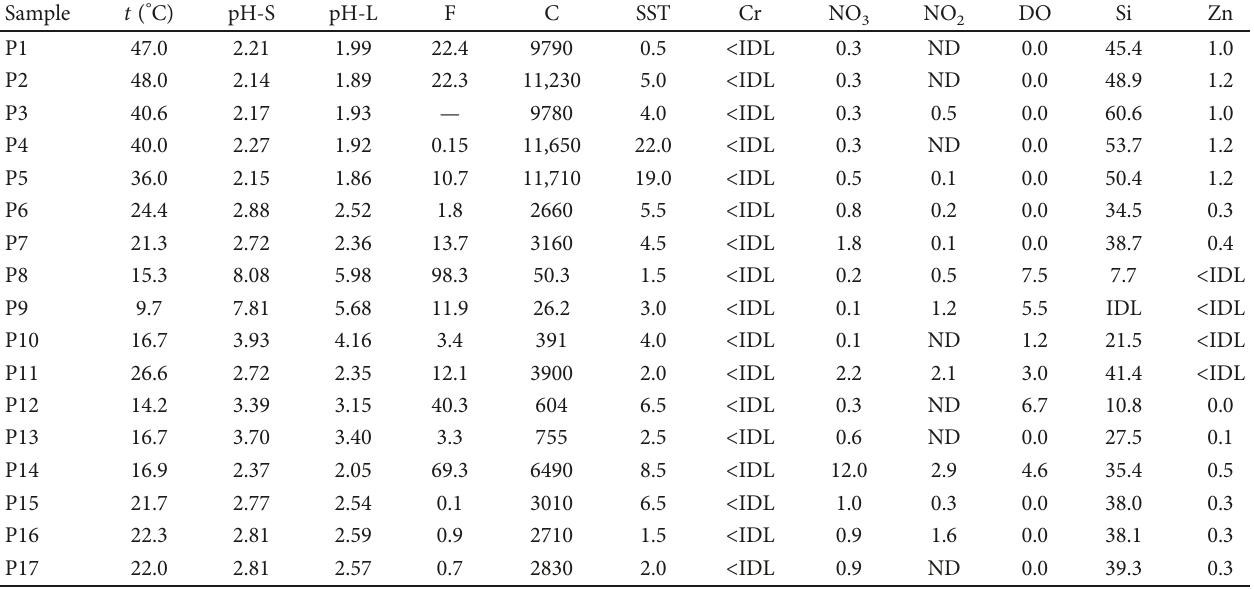
Table 4: Major element concentrations of the geothermal waters from the Puracé-La Mina sector, Cauca, Colombia. Units are in ppm; laboratory (pH-L), on site (pH-S), suspended solid totals (SST), conductivity (C) (in μ S/cm), fl ow (F) (in L/s), dissolved oxygen (DO), not detectable (ND), less than detection limit ( <